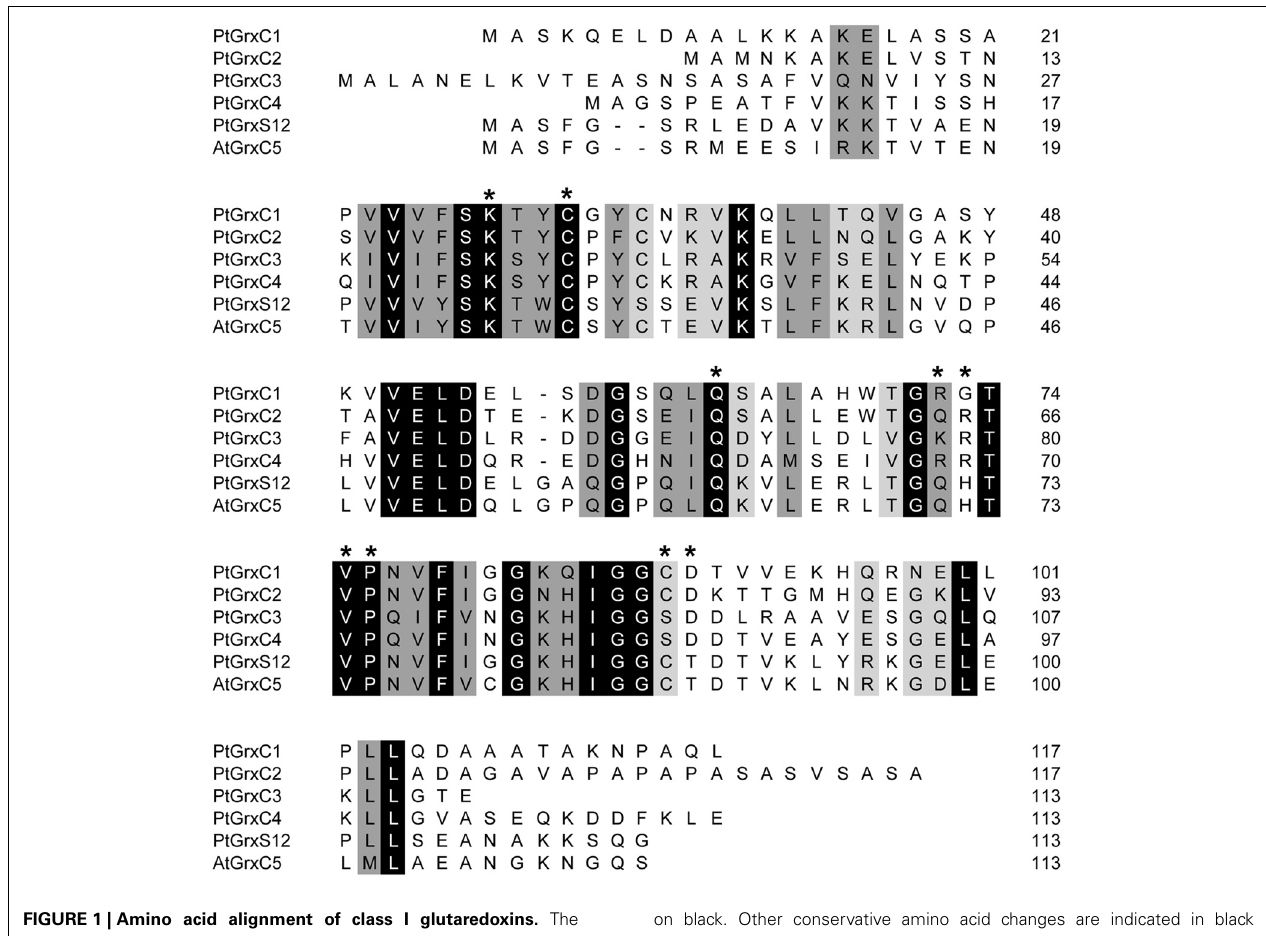
on black. Other conservative amino acid changes are indicated in black on gray. Residues involved in GSH binding based on the 3D structures of poplar GrxC4 and GrxS12 and Arabidospis GrxC5 are marked by an